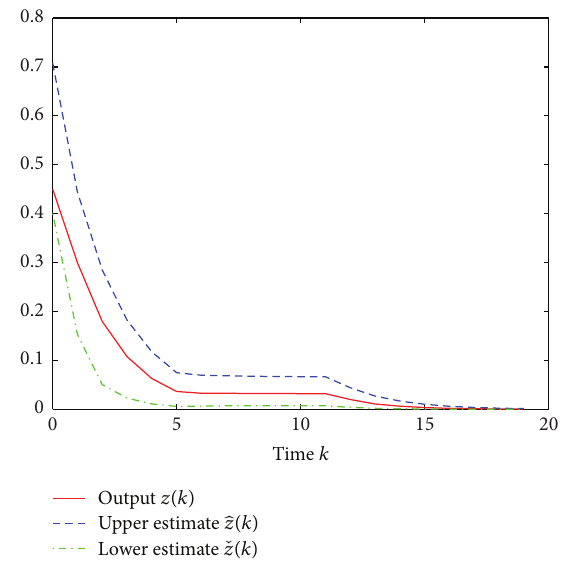
Figure 1: Output 𝑧(𝑘) and its